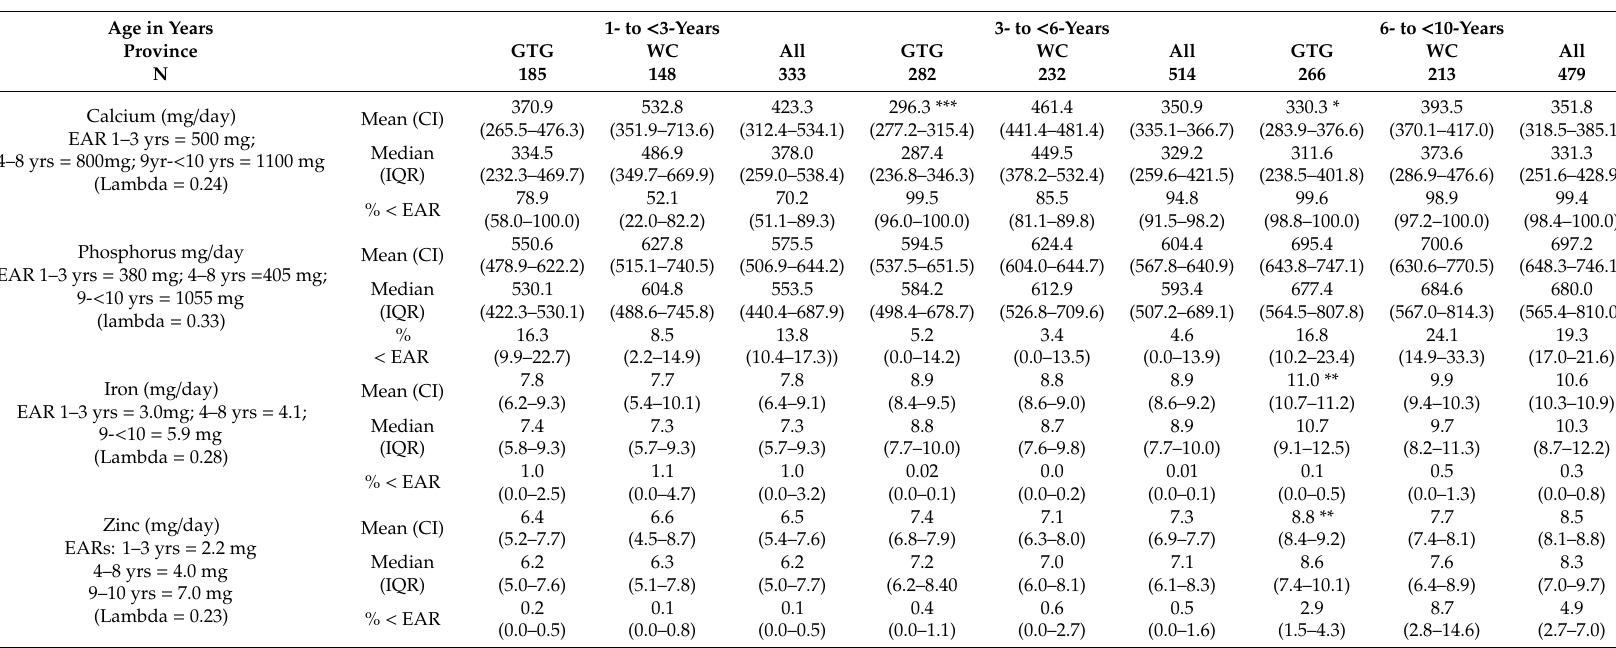
Table 2. Mean (CI), median (IQR) and percentage intake below the EAR for mineral intake (adjusted) of children aged 1 – < 10-years by province and